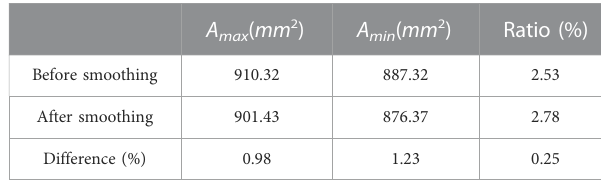
TABLE 1 The difference between the maximum and minimum POI area in one cardiac cycle before and after